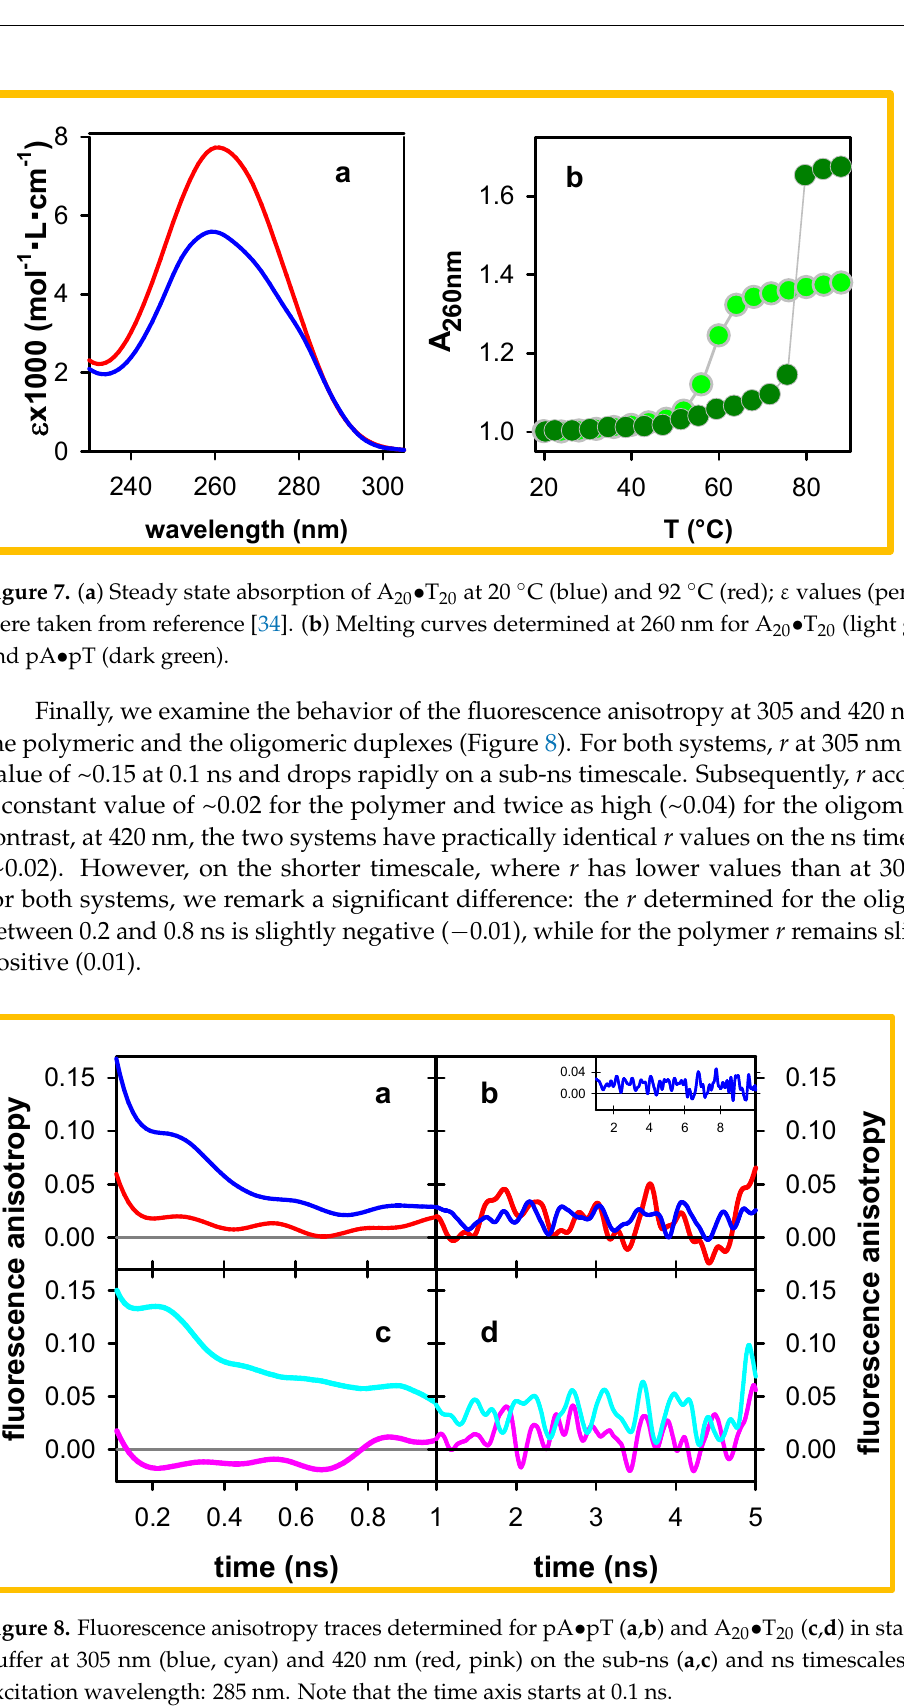
Figure 8. Fluorescence anisotropy traces determined for pA  pT ( a , b ) and A 20  T 20 ( c , d ) in standard buffer at 305 nm (blue, cyan) and 420 nm (red, pink) on the sub-ns ( a , c ) and ns timescales ( b , d ); excitation wavelength: 285 nm. Note that the time axis starts at 0.1 ns. 3. Discussion The results presented in Section 2 reveal that the fluorescence of both pA  pT and A 20  T 20 contain components emitting in the blue part of the fluorescence spectrum (Figure 1) and decaying with lifetimes of 2.2–2.7 ns (Table 1). This high-energy long-lived fluores- cence is not related to any impurities, neither in the salts present in the aqueous solution (Figure 3) nor in the DNA samples themselves. In this respect, we note that the protocol